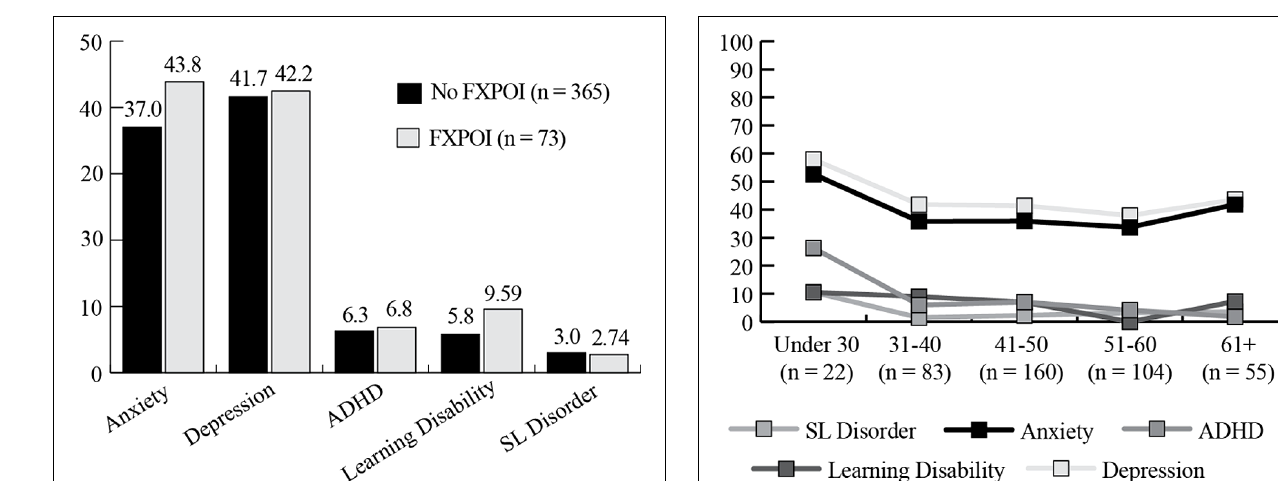
and hot flashes ( X 2 = 18.85; df = 4; p < 0.001). Headaches, menstrual symptoms, and hot flashes decreased in the older age groups, while joint pain tended to be endorsed more by older women (see Figure 6 ).